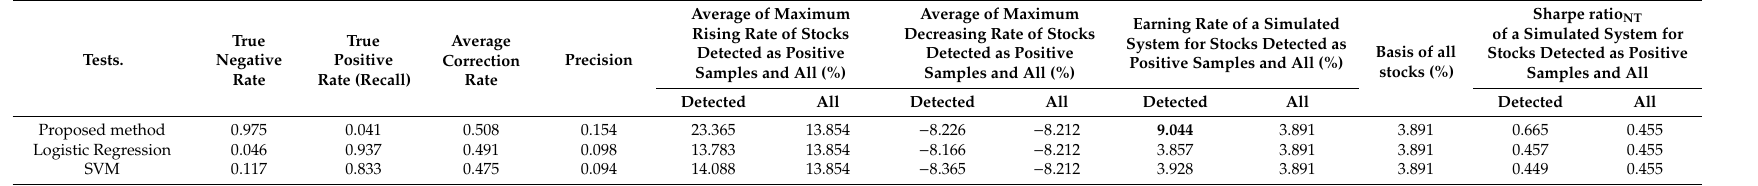
Table 9. Comparison for ranking-based stock classification considering historical volatility.